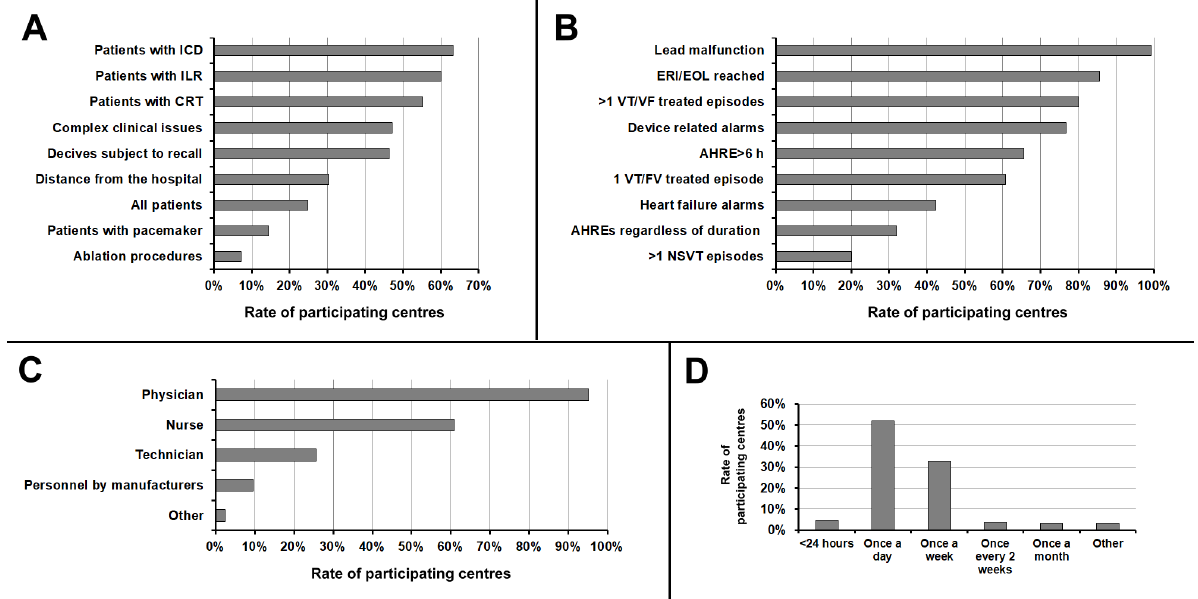
Figure 2. ( A ) Rate of use of remote monitoring according to type of CIED and patients’ characteristics. ( B ) Events considered as critical alerts to remote monitoring by the participating centres. ( C ) Professionals involved in the management of remote monitoring. ( D ) Frequency with which remote transmissions were reviewed. AHRE, atrial high rate episode; CIED, cardiac implantable electronic device; CRT, cardiac resynchronisation therapy; EOL, end-of-life; ERI, elective replacement indicator; ICD, implantable cardioverter-defibrillator; ILR, implantable loop recorder; NSVT, nonsustained ventricular tachycardia; PM, pacemaker; RM, remote monitoring; VF, ventricular fibrillation; VT, ventricular tachycardia.